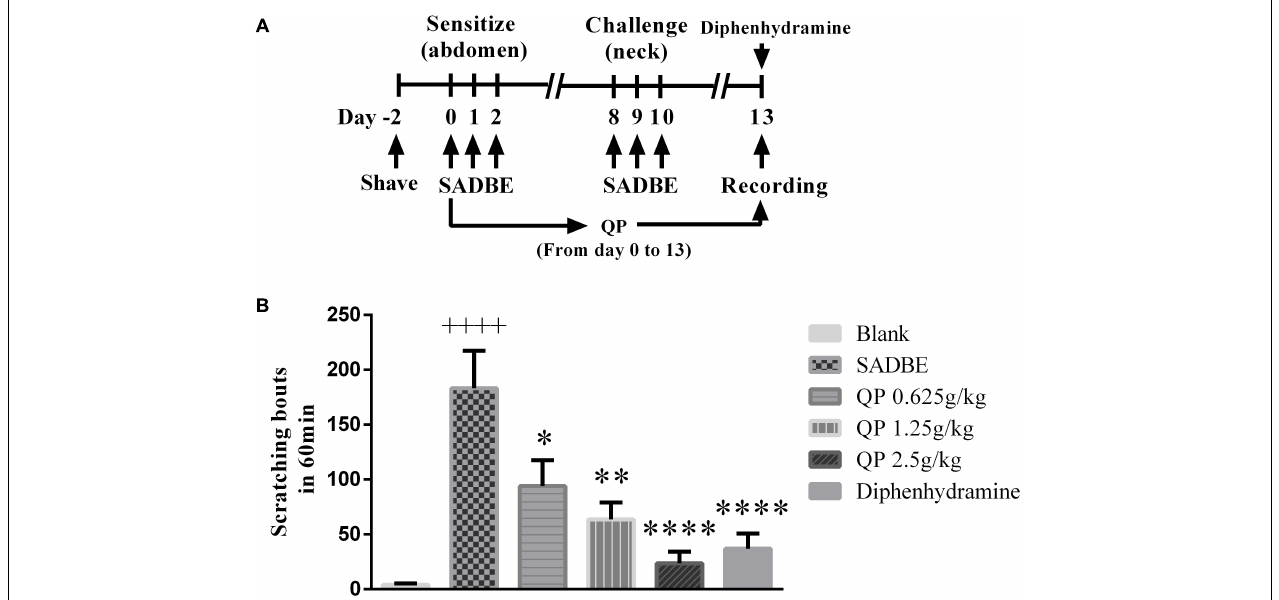
FIGURE 3 | QP reduced the itching caused by allergic contact dermatitis induced by SADBE. (A) A Schematic diagram shows the experimental protocol. 0.5% SADBE/acetone was topically treated daily 3 times to the mouse abdomen, and re-stimulated topically daily 3 times to the neck back skin after a 5 days’ break. Spontaneous scratching was videotaped and analyzed afterward. (B) The behavior results of SADBE mice in different controls or after three QP (0.625, 1.25, and 2.5 g/kg), and the positive drug (diphenhydramine, 10 mg/kg). Data was expressed as mean ± SEM. ∗ p < 0.05, ∗∗ p < 0.01, and ∗∗∗∗ p < 0.0001, compared with the model group. ++++ p < 0.0001, compared with the blank control group. One-way ANOVA followed by post hoc test ( n = 5 each group). The method and criteria to present and statistically analyze the data in (B) were followed the same in all other work in this paper unless mentioned